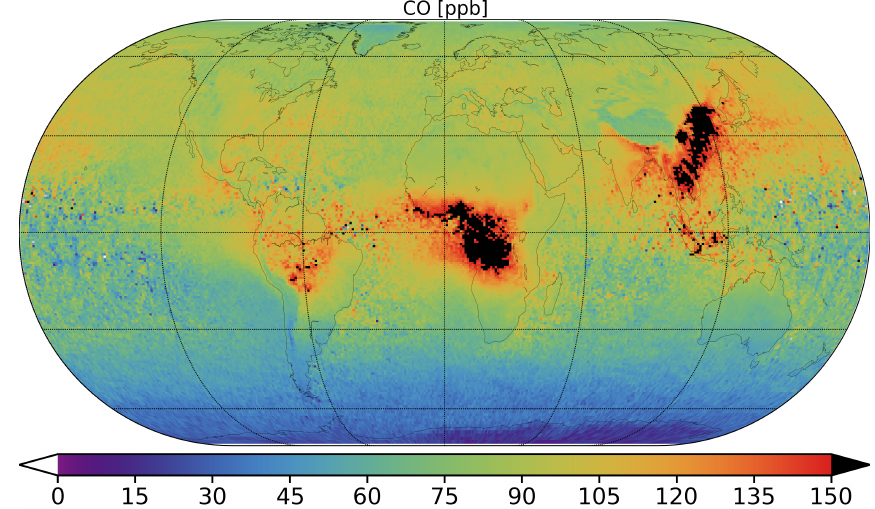
Figure 11. CO column averaged mixing ratios in ppb over land and ocean from clear-sky and cloudy-sky measurements for optically thick low cloud conditions. The values are averaged from January 2003 to the end of the SCIAMACHY mission in April 2012.